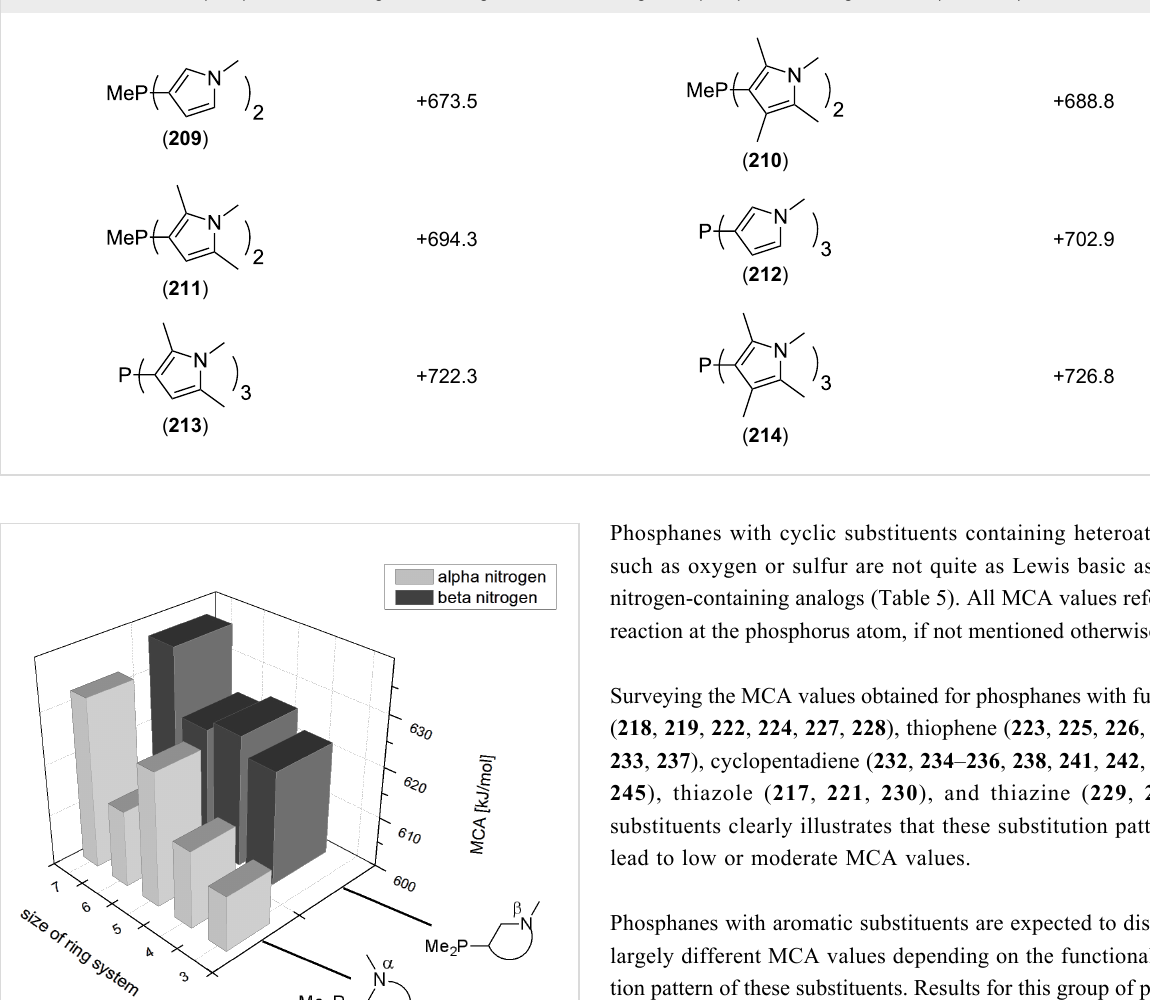
Table 4: MCA values of phosphanes with nitrogen-containing substituents lacking direct phosphorous–nitrogen bonds. (continued)